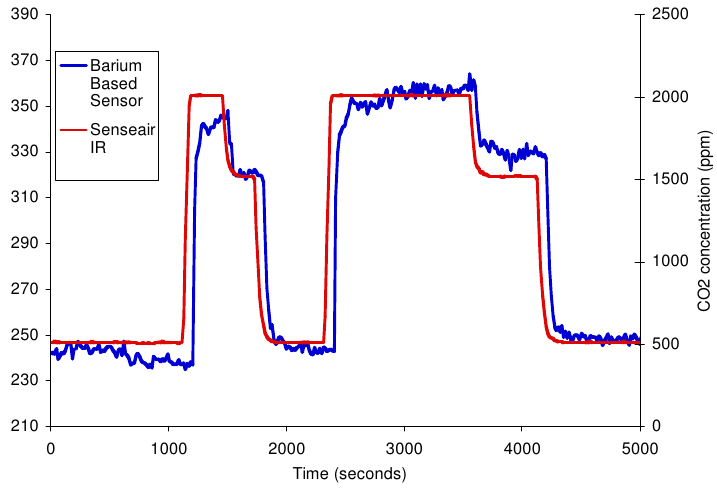
Figure 23. Comparison of CO Sensor Technologies: Commercial Senseair Infra-red 2 device versus a barium based metal oxide semiconductor sensor developed at UCL. CO concentration indicated by the K30 is plotted on right hand axis and the UCL sensor response is on left hand axis, showing a change in resistance in the MOhm